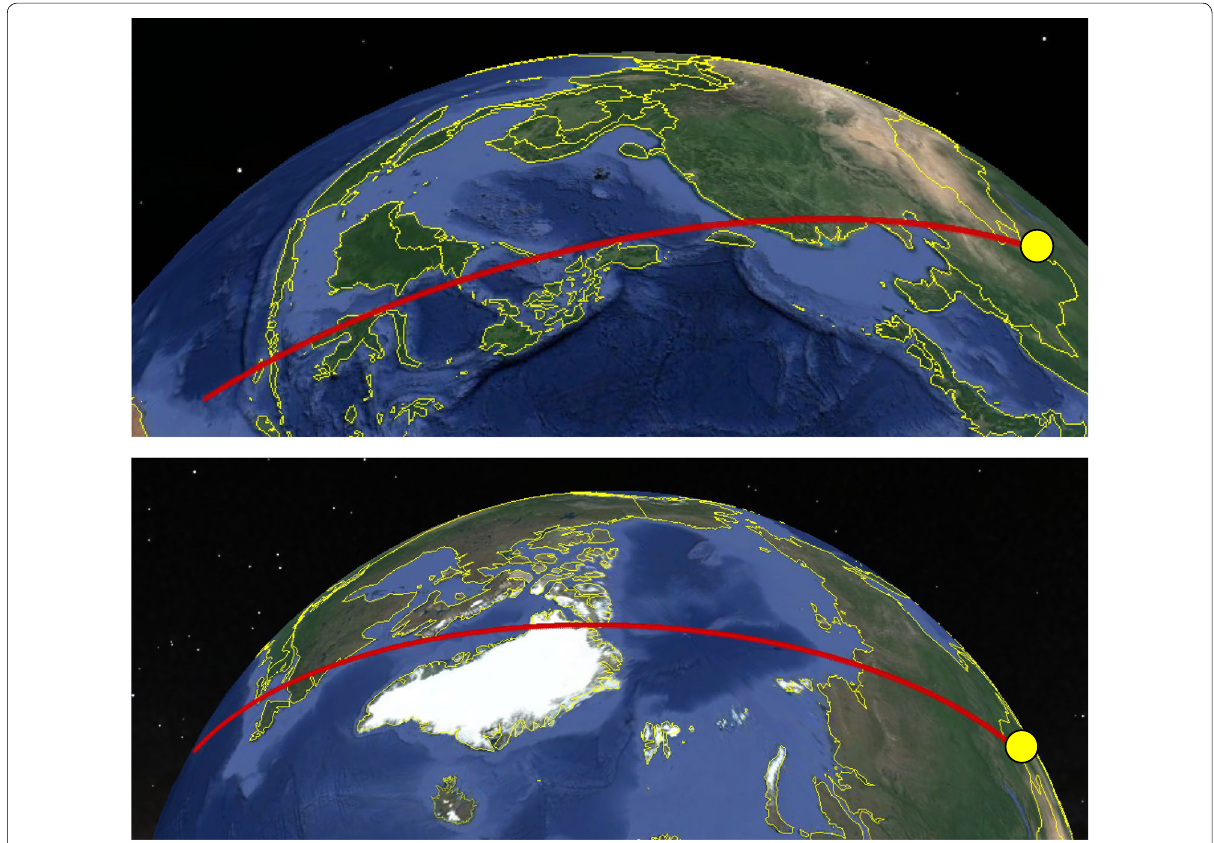
Fig. 2 Two flight scenarios. (Up) southward flight; (below) northward flight passing north pole. Yellow circles indicate starting